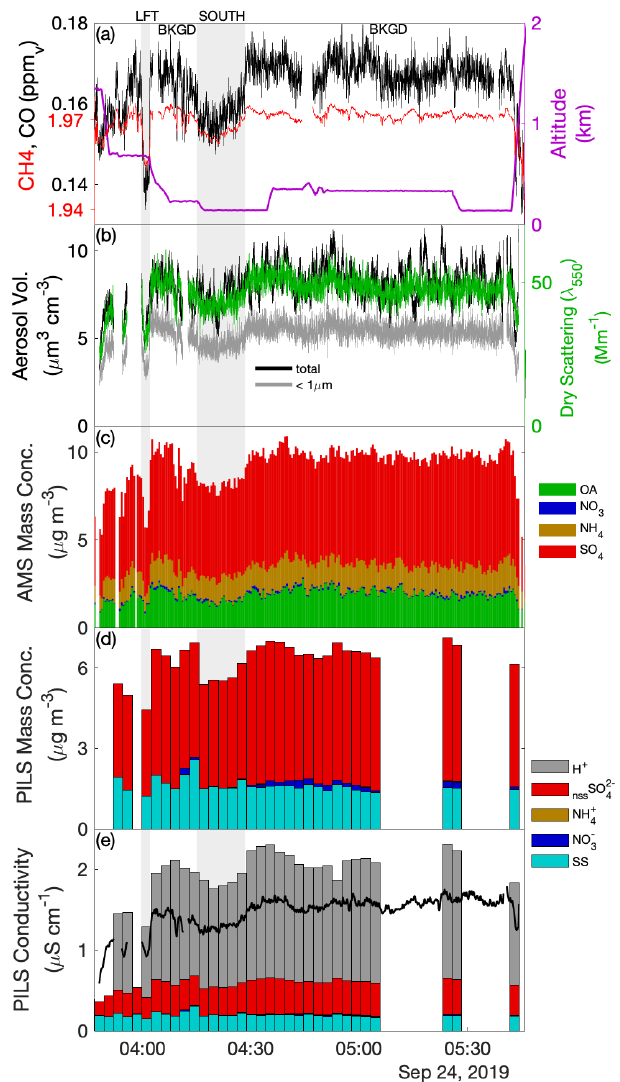
Figure 4. Like Fig. 3 for proximal low-level sampling around the cloud wall of Case